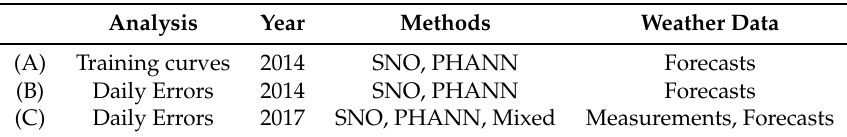
Table 2. Summary of the test cases.